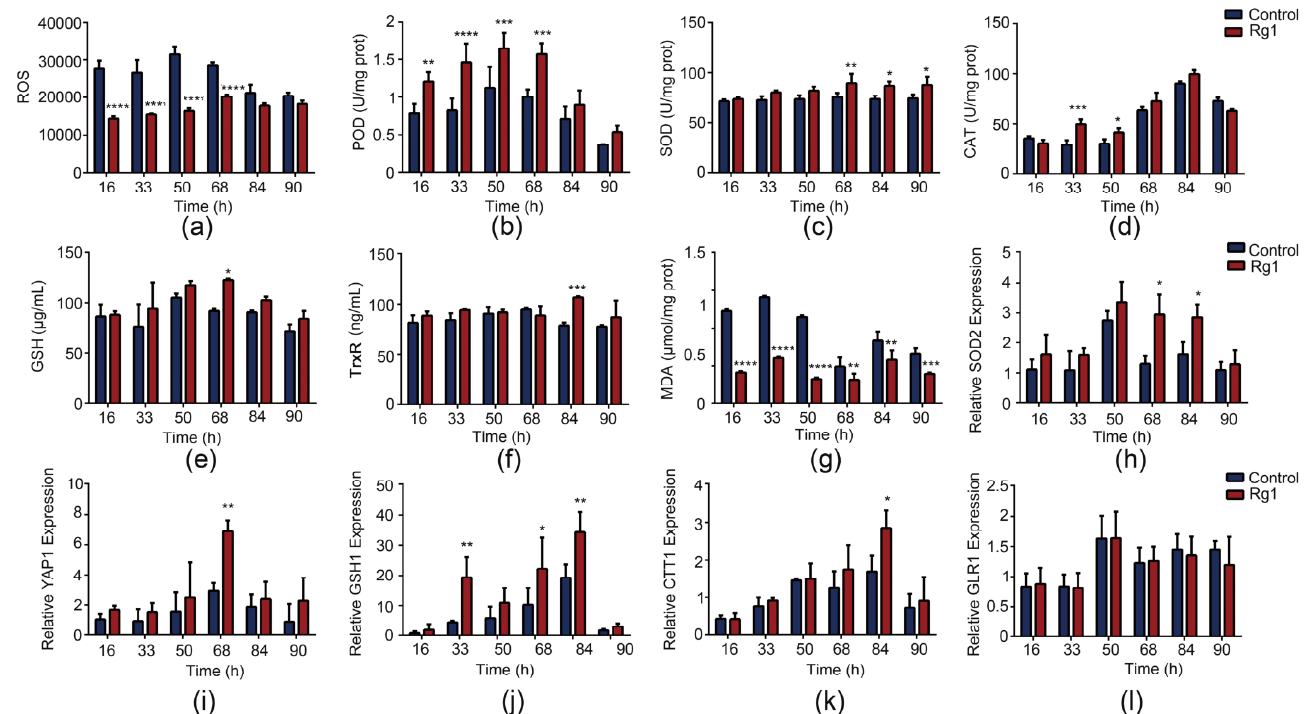
Figure 5. Measurement of intracellular ( a ) reactive oxygen species (ROS) levels, ( b ) peroxidase (POD) activity, ( c ) superoxide dismutase (SOD) activity, ( d ) catalase (CAT) activity, ( e ) glutathione (GSH) concentration, ( f ) thioredoxin (TrxR) activity, and ( g ) malondialdehyde (MDA) concentration with or without Rg1 (180 μg/mL) treatment. Analysis of antioxidant-related gene expression in yeast cells ( h , SOD2 ; i , YAP1 ; j , GSH1 ; k , CTT1 ; l , GLR1 ) by qRT–PCR in cells with or without Rg1 treatment. Data are expressed as the mean ± SD; n = 3. Compared with untreated controls, * p < 0.05, ** p < 0.01, *** p < 0.001, **** p < 0.0001.